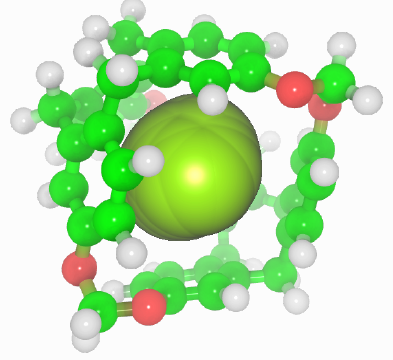
Figure 8. Representation of the accessible volume of the cavity calculation of